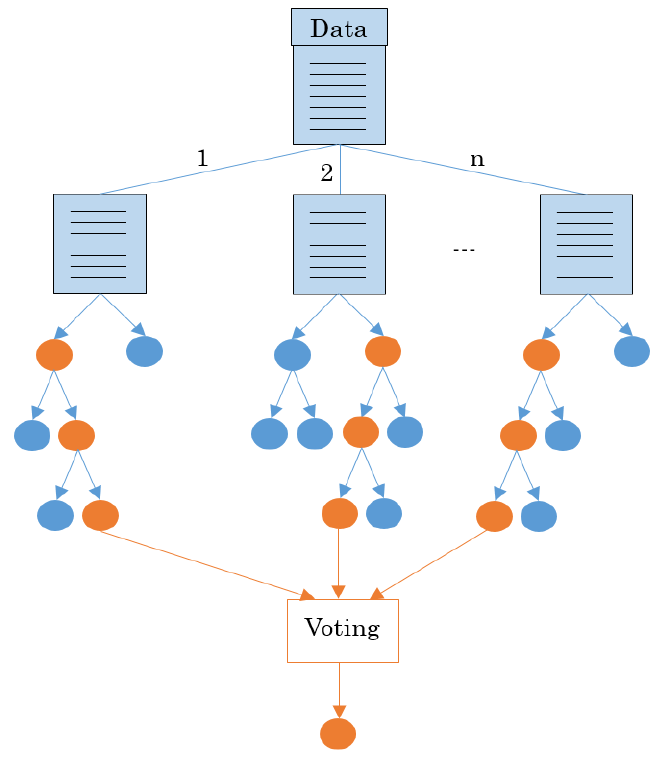
Figure 9. General procedure of Random Forest.